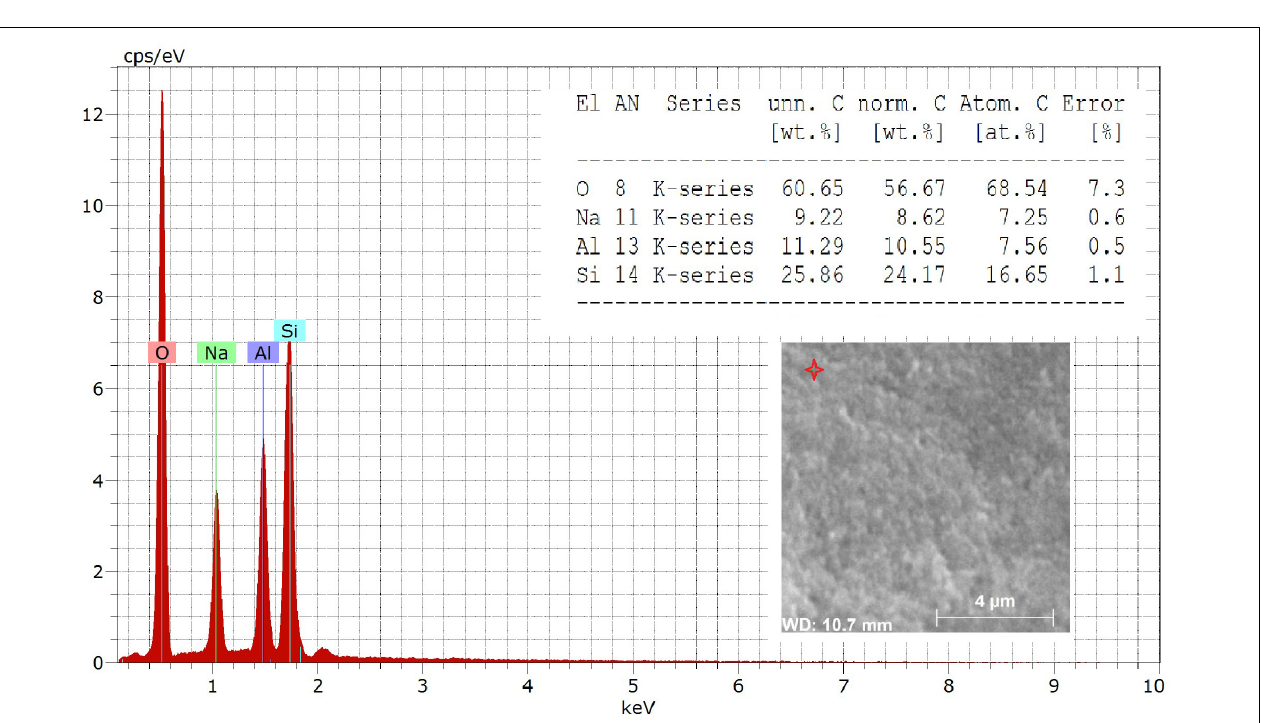
FIGURE 5 | EDX analysis of the geopolymer